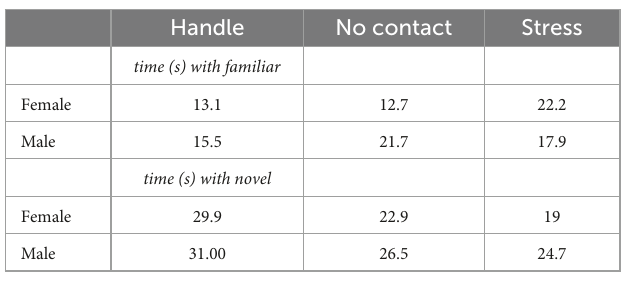
TABLE 1 Interaction time with conspecifics during recognition test.